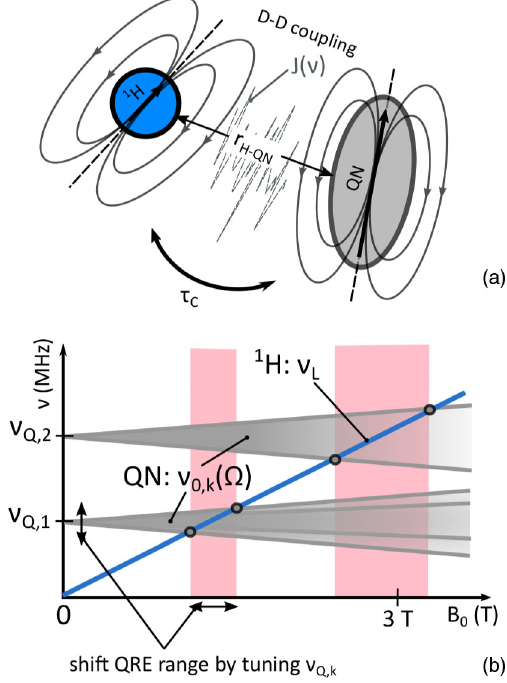
FIG. 2. (a) The schematic principle of QRE in protons due to the interaction with close-by QN via magnetic D-D coupling. (b) The transition frequencies of both spin ensembles, ν L for the protons (blue line) and ν 0 ;k ð Ω Þ for the QNs (grey), depending on an externally applied flux density B 0 . Where transitions of both spin ensembles match, QRE can be expected as for the considered case at 3 T. This area is indicated by the vertical red bands. Panel (b) also gives an impression of how the QRE peaks are shifted by tuning the pure quadrupole